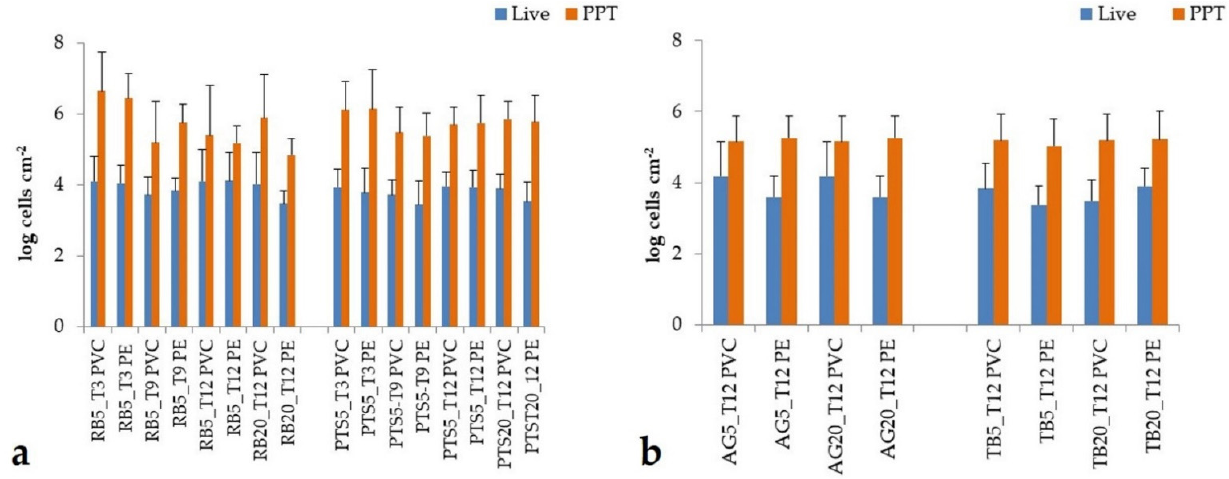
Figure 4. Mean values + standard deviations of total prokaryotic (PPT) and living (Live) cell abundance measured in the microbial biofilm developed on plastic panels submerged for 3, 9 and 12 months (T3, T9 and T12, respectively) at 5 and 20 m. ( a ) Road Bay area; ( b ) Tethys Bay area. RB, Road Bay (impact station, on the left); PTS, Punta Stocchino (control station, on the right); AG, Amorphous Glacier (impact station, on the left); TB, Tethys Bay (control station, on the right); PVC: Polyvinyl chloride; PE: Polyethylene. The fraction of viable cells (Live) on PVC comprised between 5.29 × 10 3 and 1.27 × 10 4